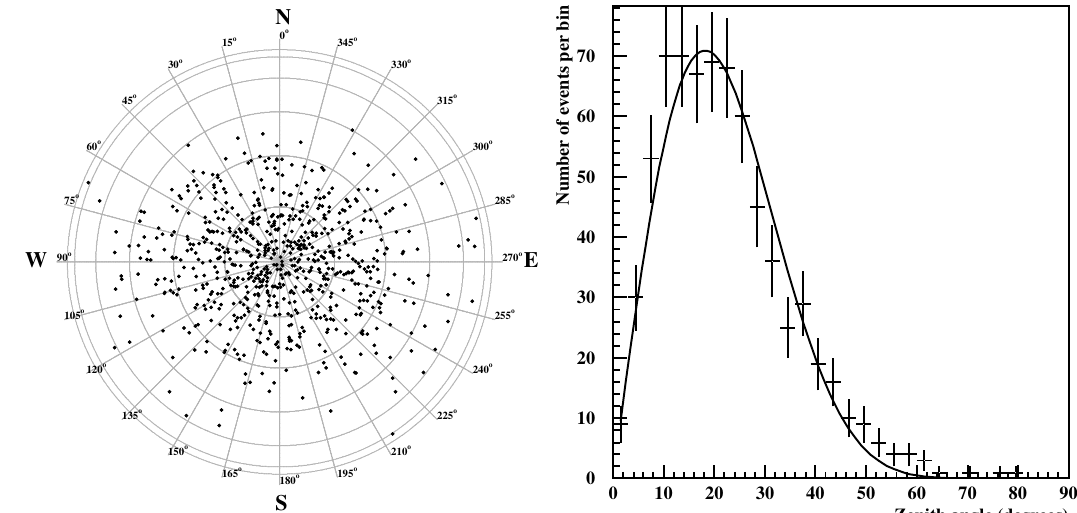
Figure 8. ( Left ): Plane projection of the reconstructed EAS directions, where the cardinal points are shown. The gray circles are lines of constant zenith every 15 ◦ and the radial lines are lines of constant azimuth. ( Right ): The distribution of the reconstructed shower’s